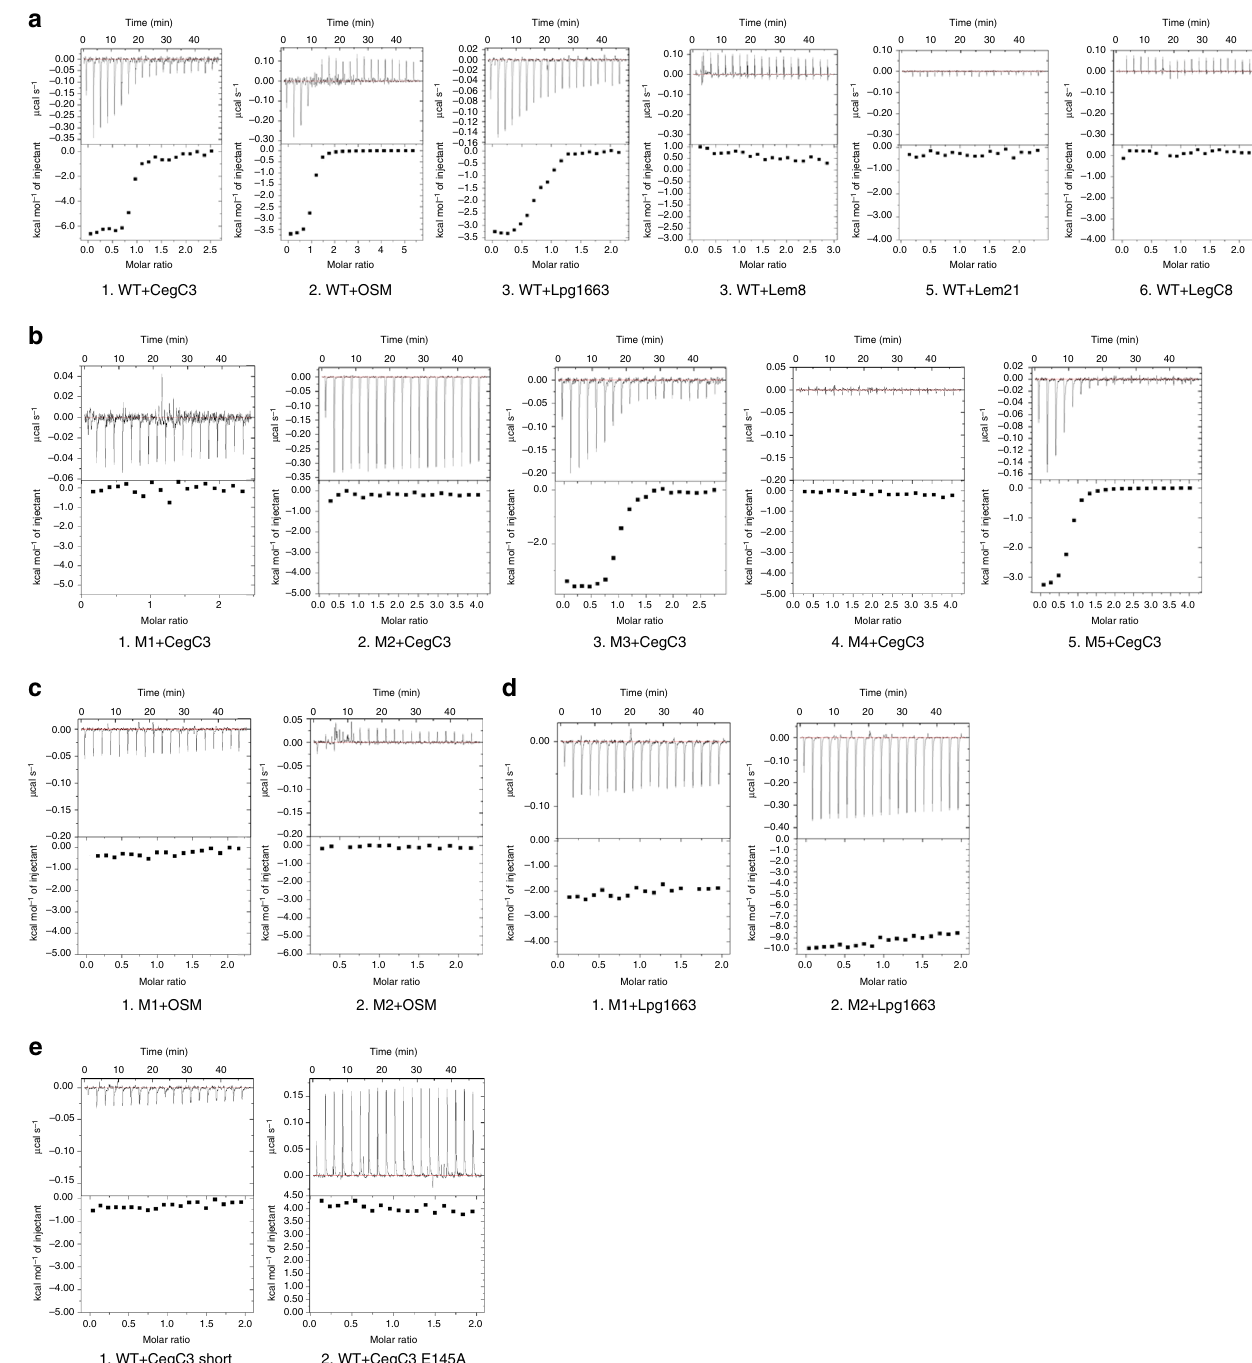
Fig. 4 Binding of DotM153 and DotM153 variants to various effectors ’ C-terminal tail peptides. a ITC of effector peptide binding to wild-type (WT) DotM153. Glu-rich peptides CegC3, OSM, and Lpg1663 (A1, A2, and A3, respectively) showed high af fi nity toward DotM, whereas peptides lacking this motif, Lem8, Lem21, and LegC8 (A4, A5, and A6, respectively) did not show any detectable binding. b ITC of CegC3 peptide binding to DotM153 mutants (M1 – 5). While mutants M1, M2, and M4 (B1: R196E/R197E, B2: R314E/R315E, and B4: R217, respectively) abolished binding, mutants 3 and 5 (B3: R347E/ R348E and B5: R262, respectively) maintained properties similar to the wild-type DotM153. c ITC of OSM peptide binding to DotM153 mutants M1 and M2. The af fi nity of M1 (C1) and M2 (C2) was measured against the OSM peptide, yielding similar results as CegC3 peptide binding to M1 and M2. d ITC of Lpg1663 peptide binding to DotM153 mutants M1 and M2. The af fi nity of M1 (D1) and M2 (D2) was measured against the Lpg1663 peptide, yielding similar results as CegC3 peptide binding to M1 and M2. e ITC of a shorter version of CegC3 (E1) (see Table 2 for sequence) and CegC3 mutant E145A (E2) to wild-type